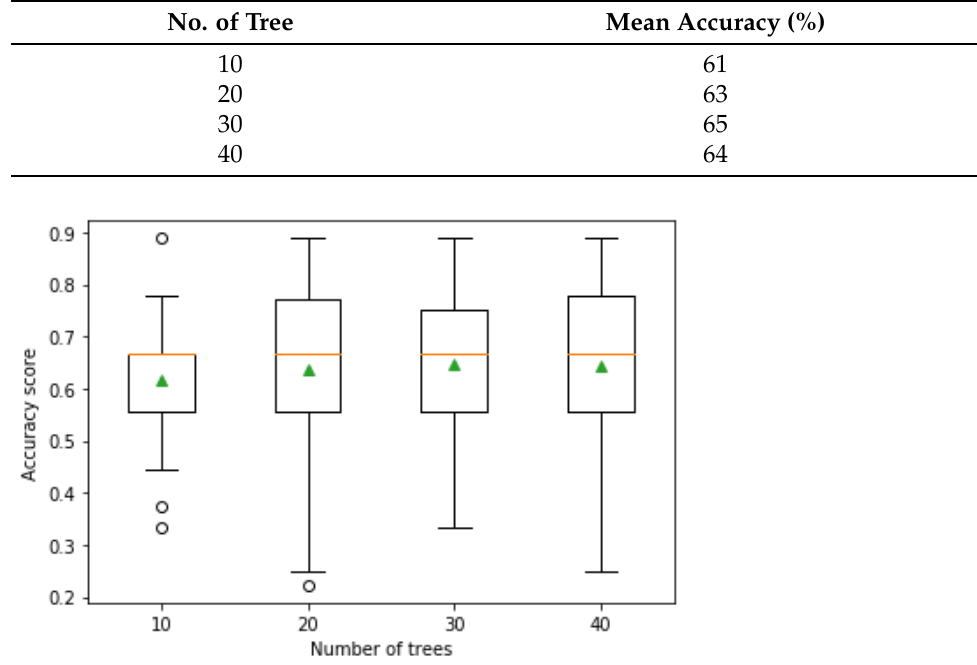
Table 15. Pohang: Predictive accuracy score against number of trees for each ensemble.